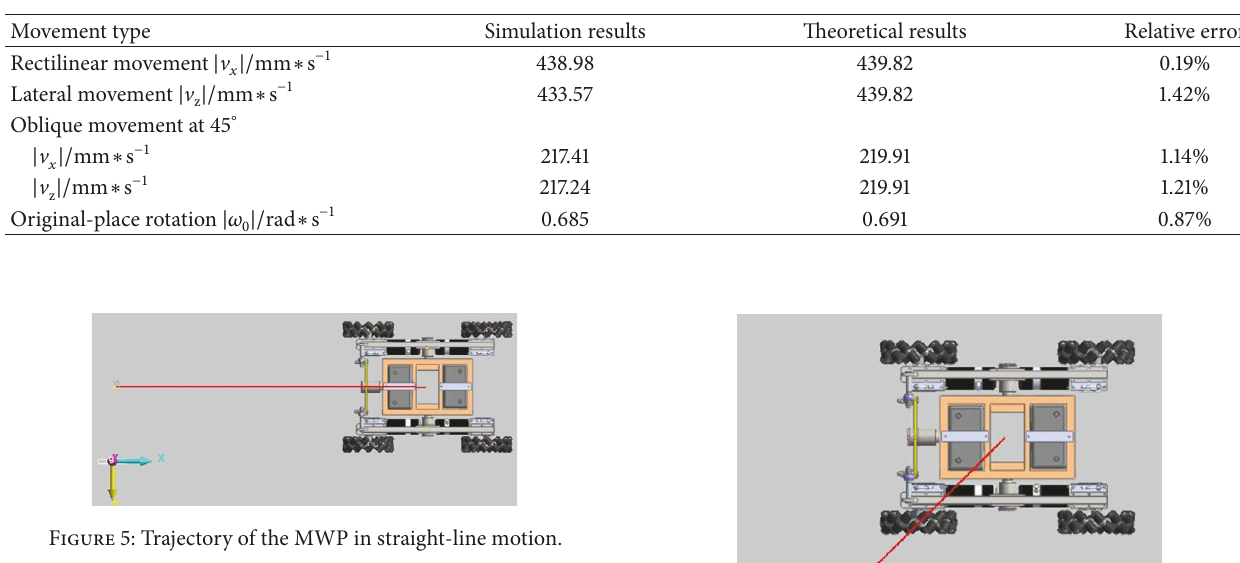
Table 2: Comparison between simulation results and theoretical results of the platform motion velocity.